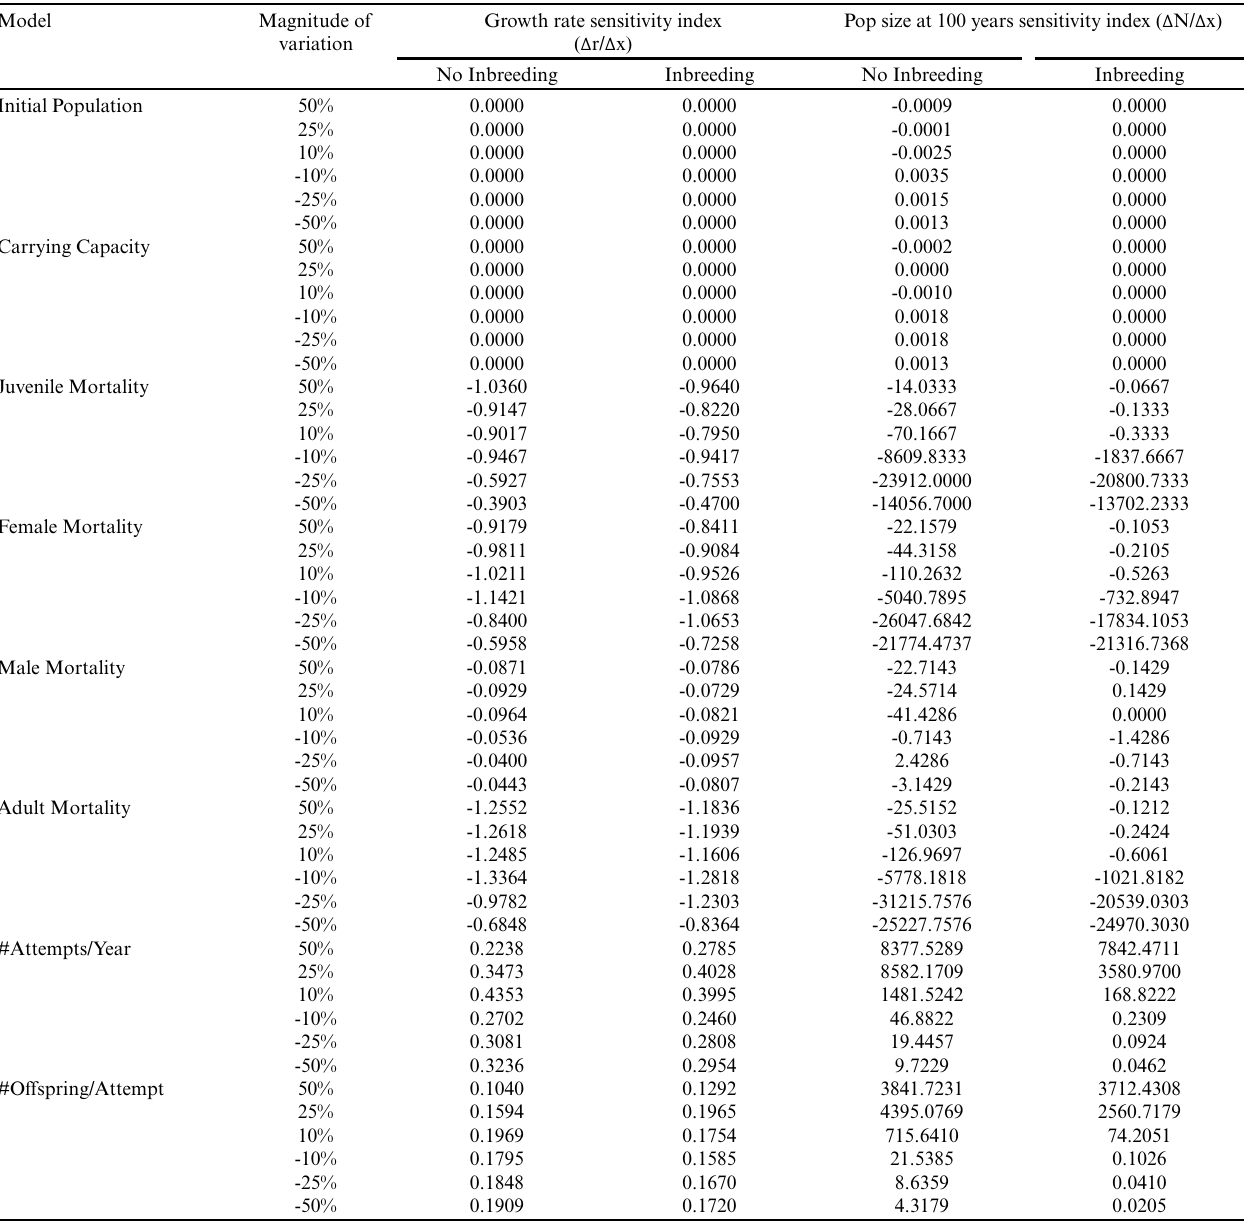
Table 2 . Sensitivity analysis of key input parameter influencing Nightingale Reed-Warbler ( Acrocephalus hiwae ) growth rate and population size at 100 years, without and with